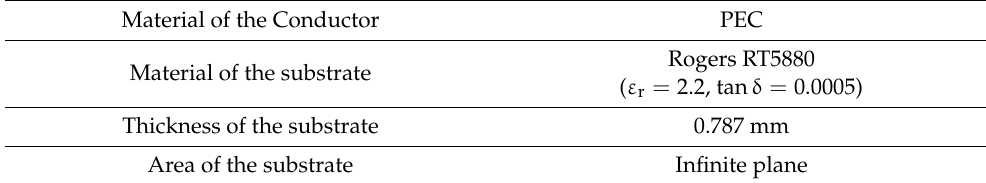
Table 2. Designed range and definition of each parameter.